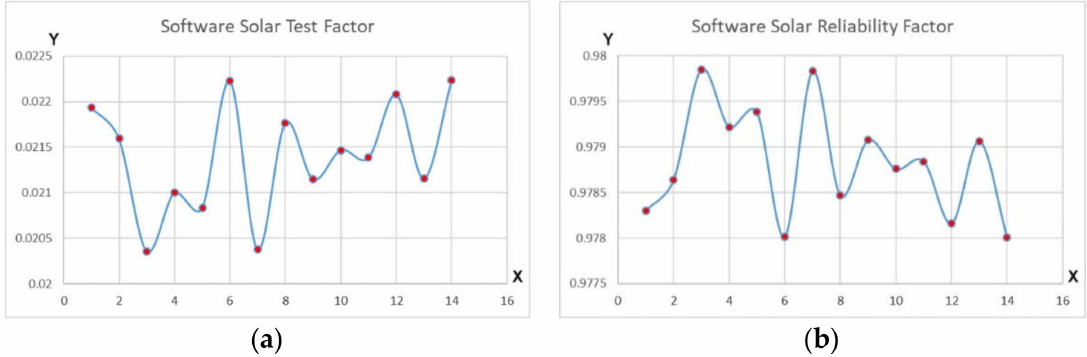
Figure 7. Hybrid testing suite for software test scenarios: ( a ) software STF generated according to the total number of syntax errors; X -axis representing the number of days; Y -axis representing the software STF parameter; ( b ) software SRF generated according to the software STF parameter; X -axis representing the number of days; Y -axis representing the software SRF parameter; adapted from [16].